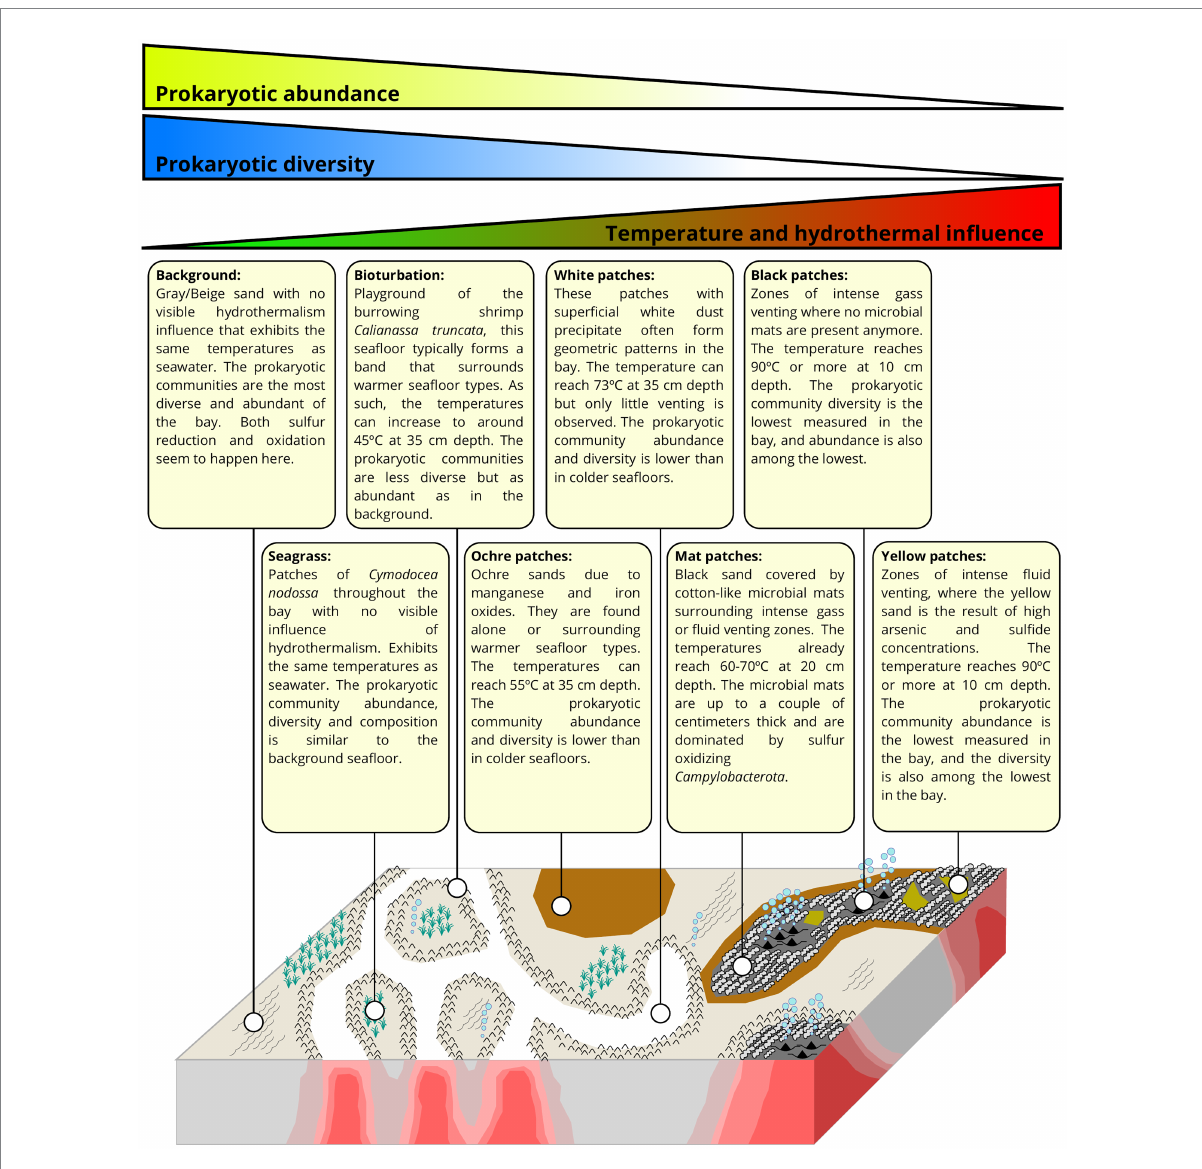
FIGURE 6 Description of the various seafloors observed in Paleochori Bay, along with the general trends of abundance, diversity, and composition of the prokaryotic communities (modified from the hydrothermal distribution model for Milos in Puzenat et al.